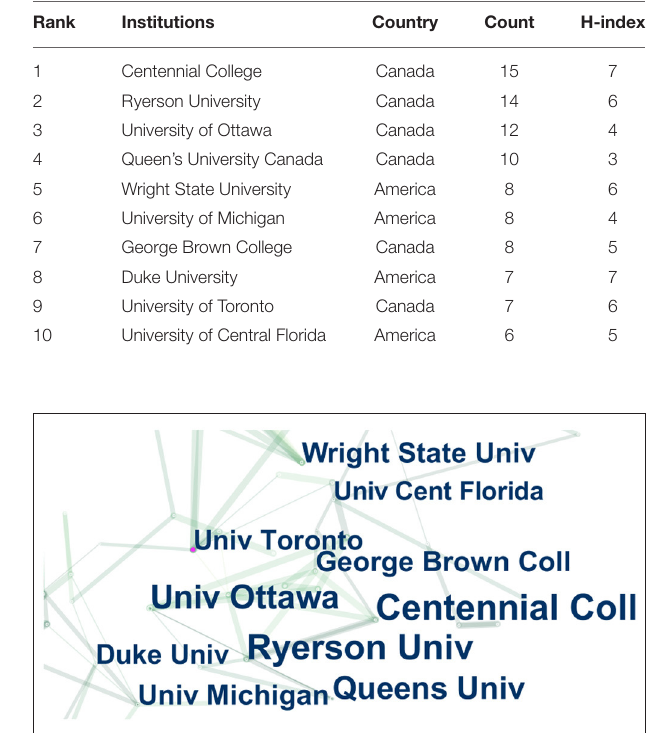
TABLE 2 | The top 10 institutions with publications on the application of VR in nursing from 2012 to 2021.